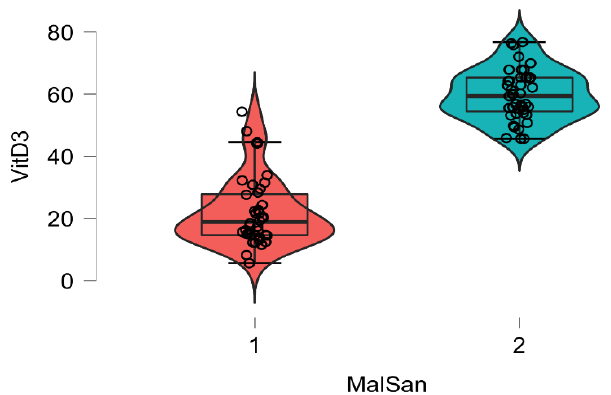
Figure 4. Boxplot showing the plasma concentration of IL-6 within 48 h of hospitalization in patients with COVID-19 (red) and healthy individuals.